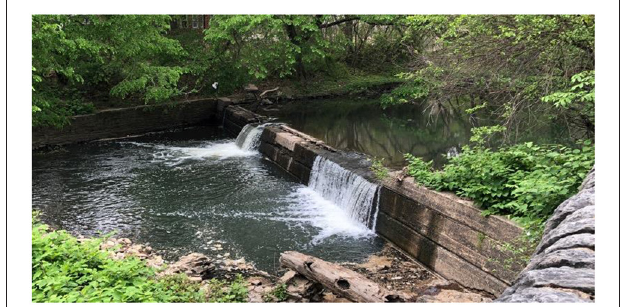
FIGURE 9 | Small dam located just downstream site F and upstream of site G.